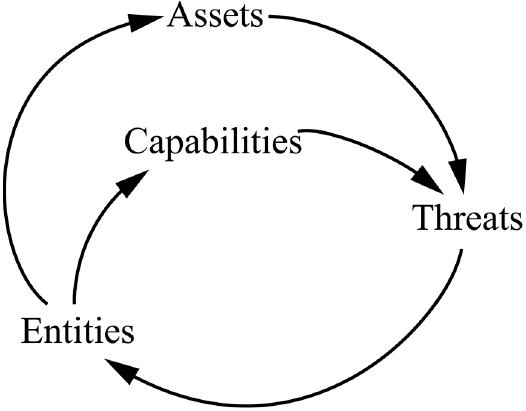
Figure 4. General influence diagram of the basic structure of the Cyber Security Ecosystem of Colombia.